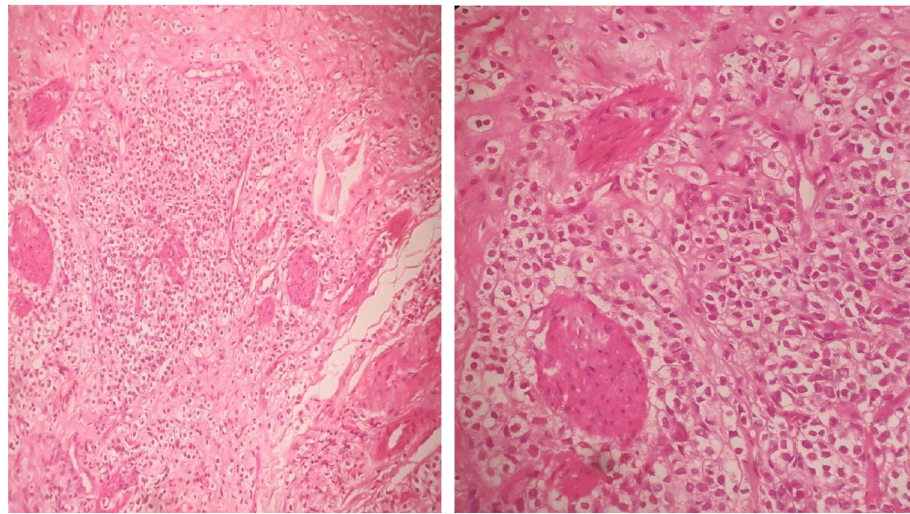
Figure 4: A carcinomatous tumor proliferation located in a small cell stroma, a cytoplasmic shelter, and a monomorphic nucleus sometimes nucleated in the scrotal skin tissue.